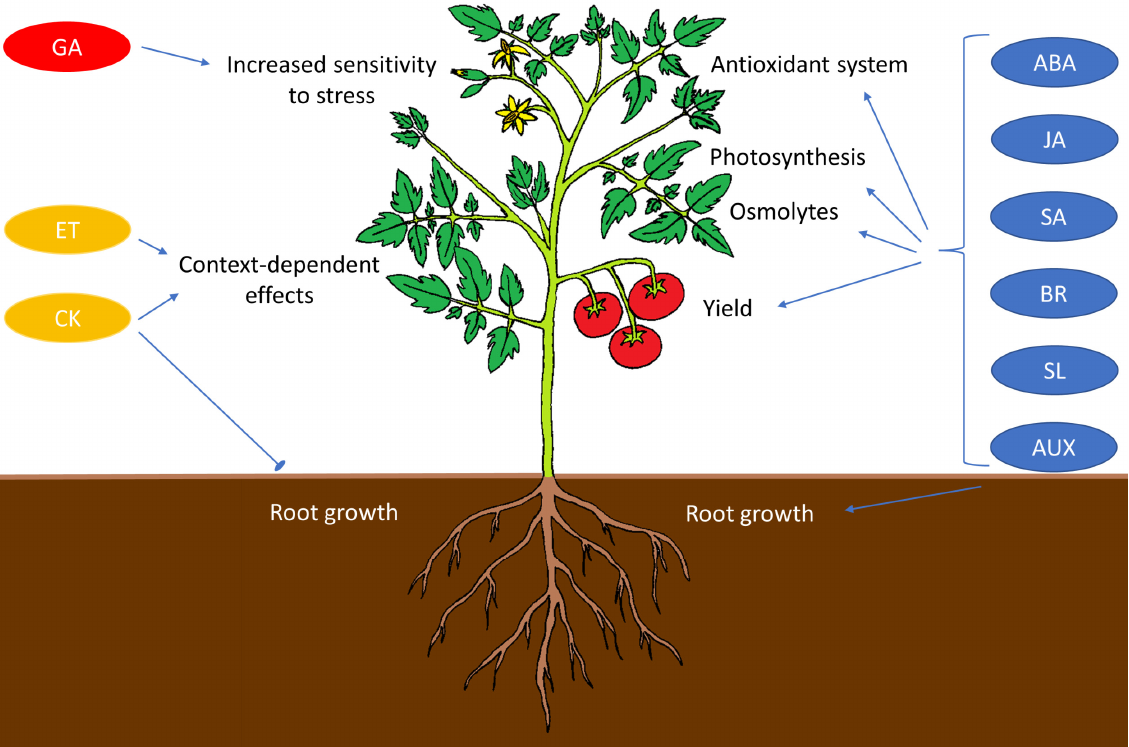
Figure 8. Role of phytohormones in plant stress response. Hormones with an overall positive effect are visualized by blue ovals. Hormones visualized by yellow ovals have been shown to have positive and negative effects on plant stress resistance in different studies. GAs visualized by red ovals mainly increase sensitivity to abiotic stress. More details about the function of hormones in stress responses in crops are shown in Table 3.